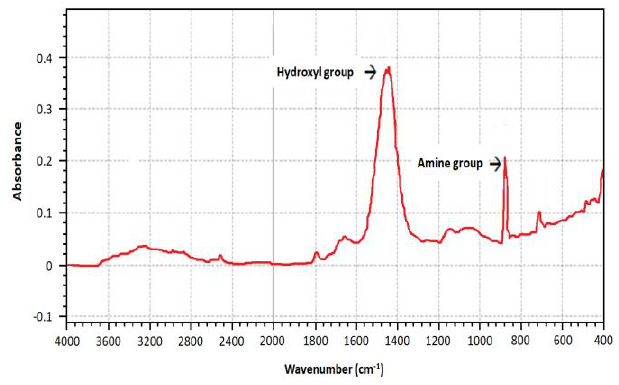
Fig 2. The analysis result of EPS by spectroscopy of FTIR Based on the literatures review, epoxy resin and EPS have the capability of Chromium sorption. As shown in Fig. 1,